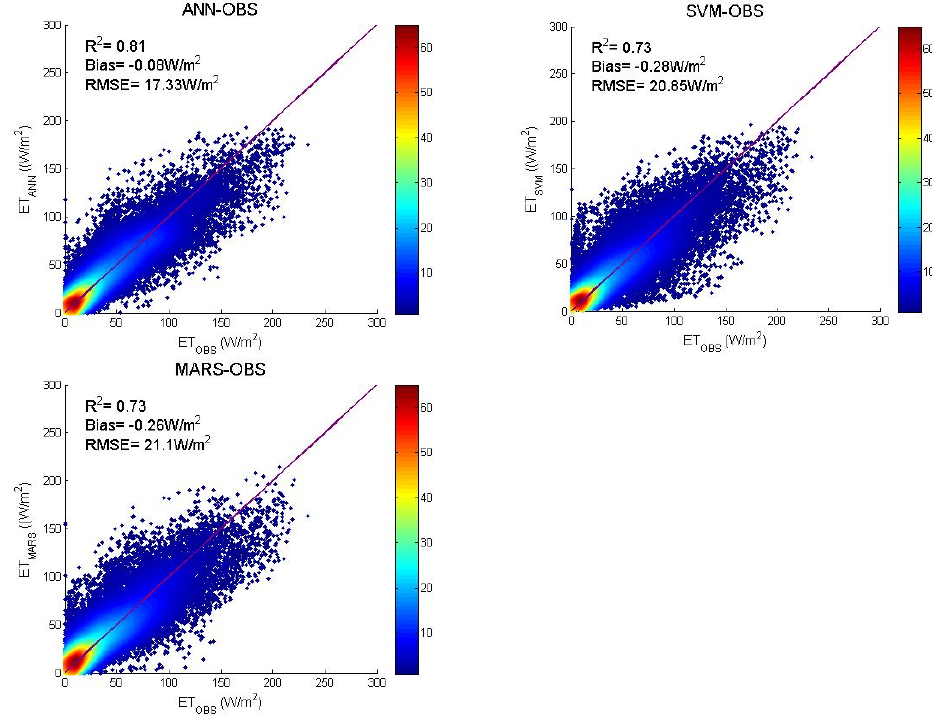
Figure 9. Comparison of daily LE observations for all 85 flux tower sites and LE estimates using different machine learning algorithms driven by tower-specific meteorology.